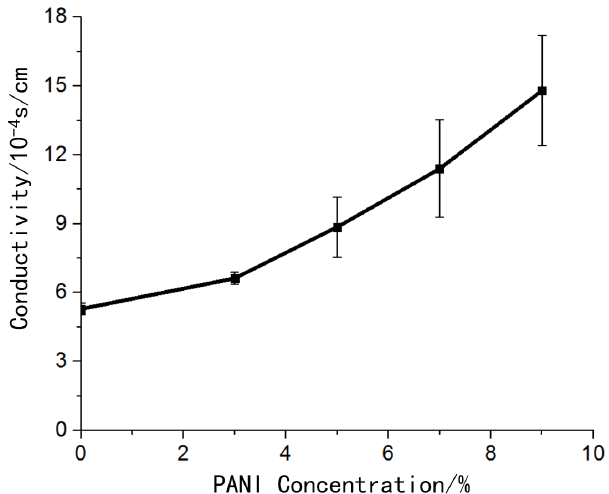
Figure 5. Conductivity change curve of bio-conductive materials with different polyaniline concen- trations.